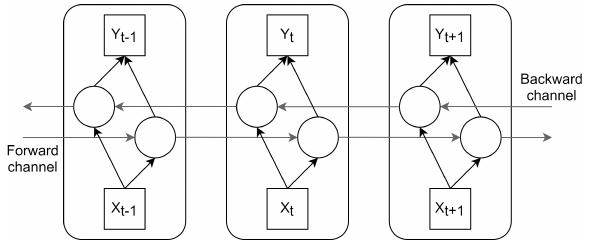
Figure 4. Bidirectional LSTM NN.